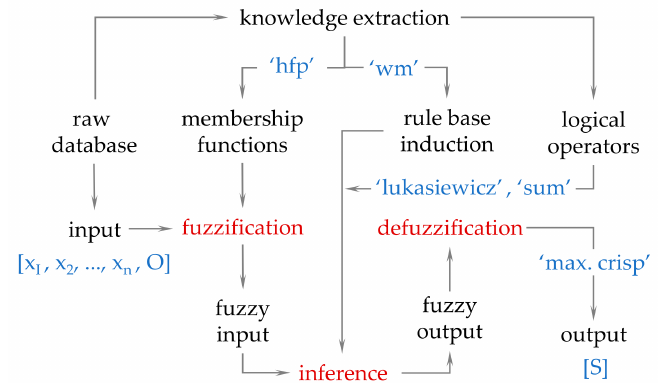
Figure 4. Modeling process of the data-driven fuzzy inference system (D 2 FIS), considering the water quality parameters as input and the coagulant dosage as